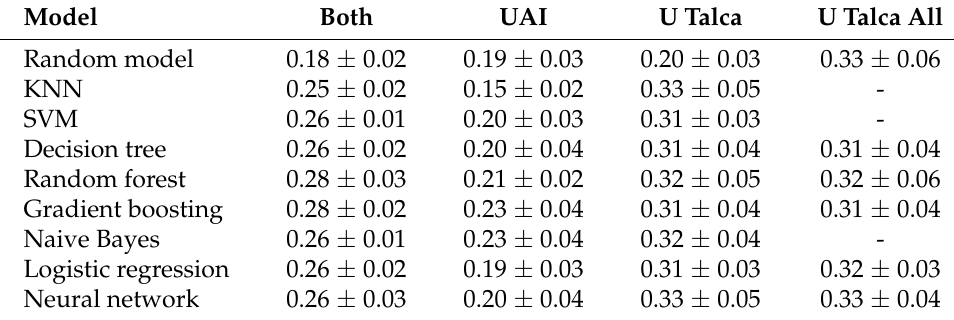
Table 5. Precision + class, for each dataset.